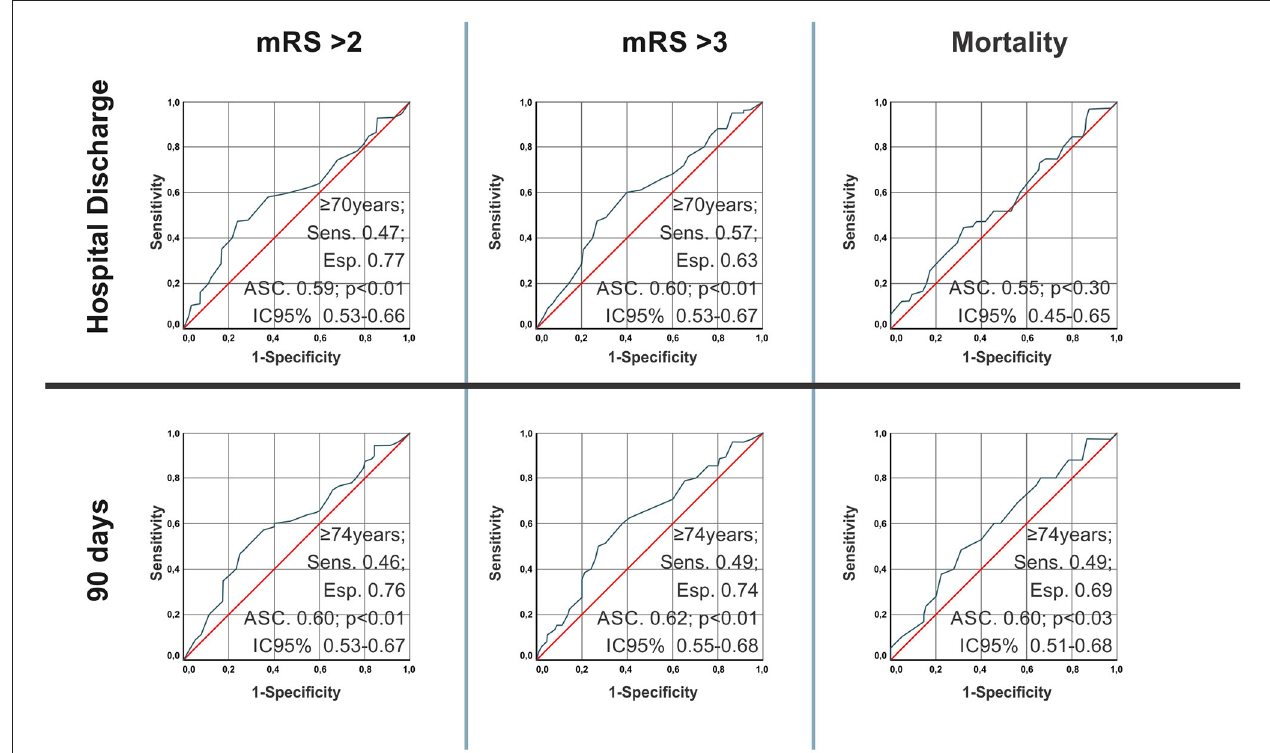
FIGURE 3 | Age discriminatory power for the outcomes of mRS > 2, mRS > 3, and death (mRS = 6) at hospital discharge and after 90 days.